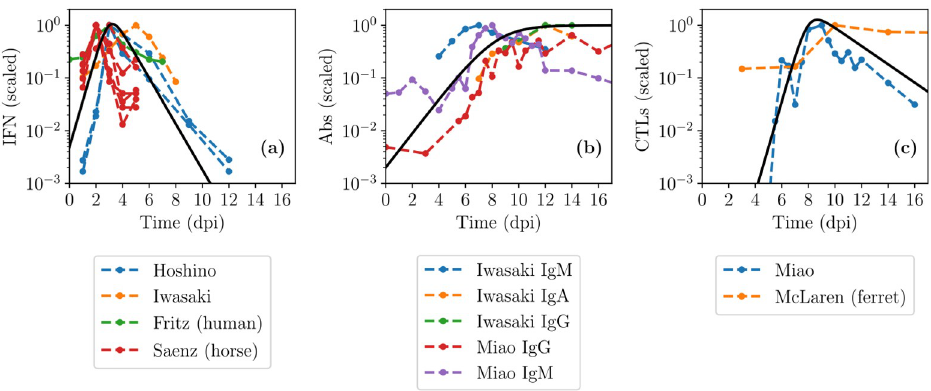
Fig 8. Time courses of key immune response components during IAV infections in vivo. Empirical MM curves (solid, black) are shown against experimental measurements (dashed, coloured) for (a) interferon (IFN) [43–46], (b) antibodies (Abs) [45, 47]; and (c) cytotoxic T lymphocytes (CTLs) [47, 48], taken over the course of in vivo IAV infections in mice, unless otherwise specified.